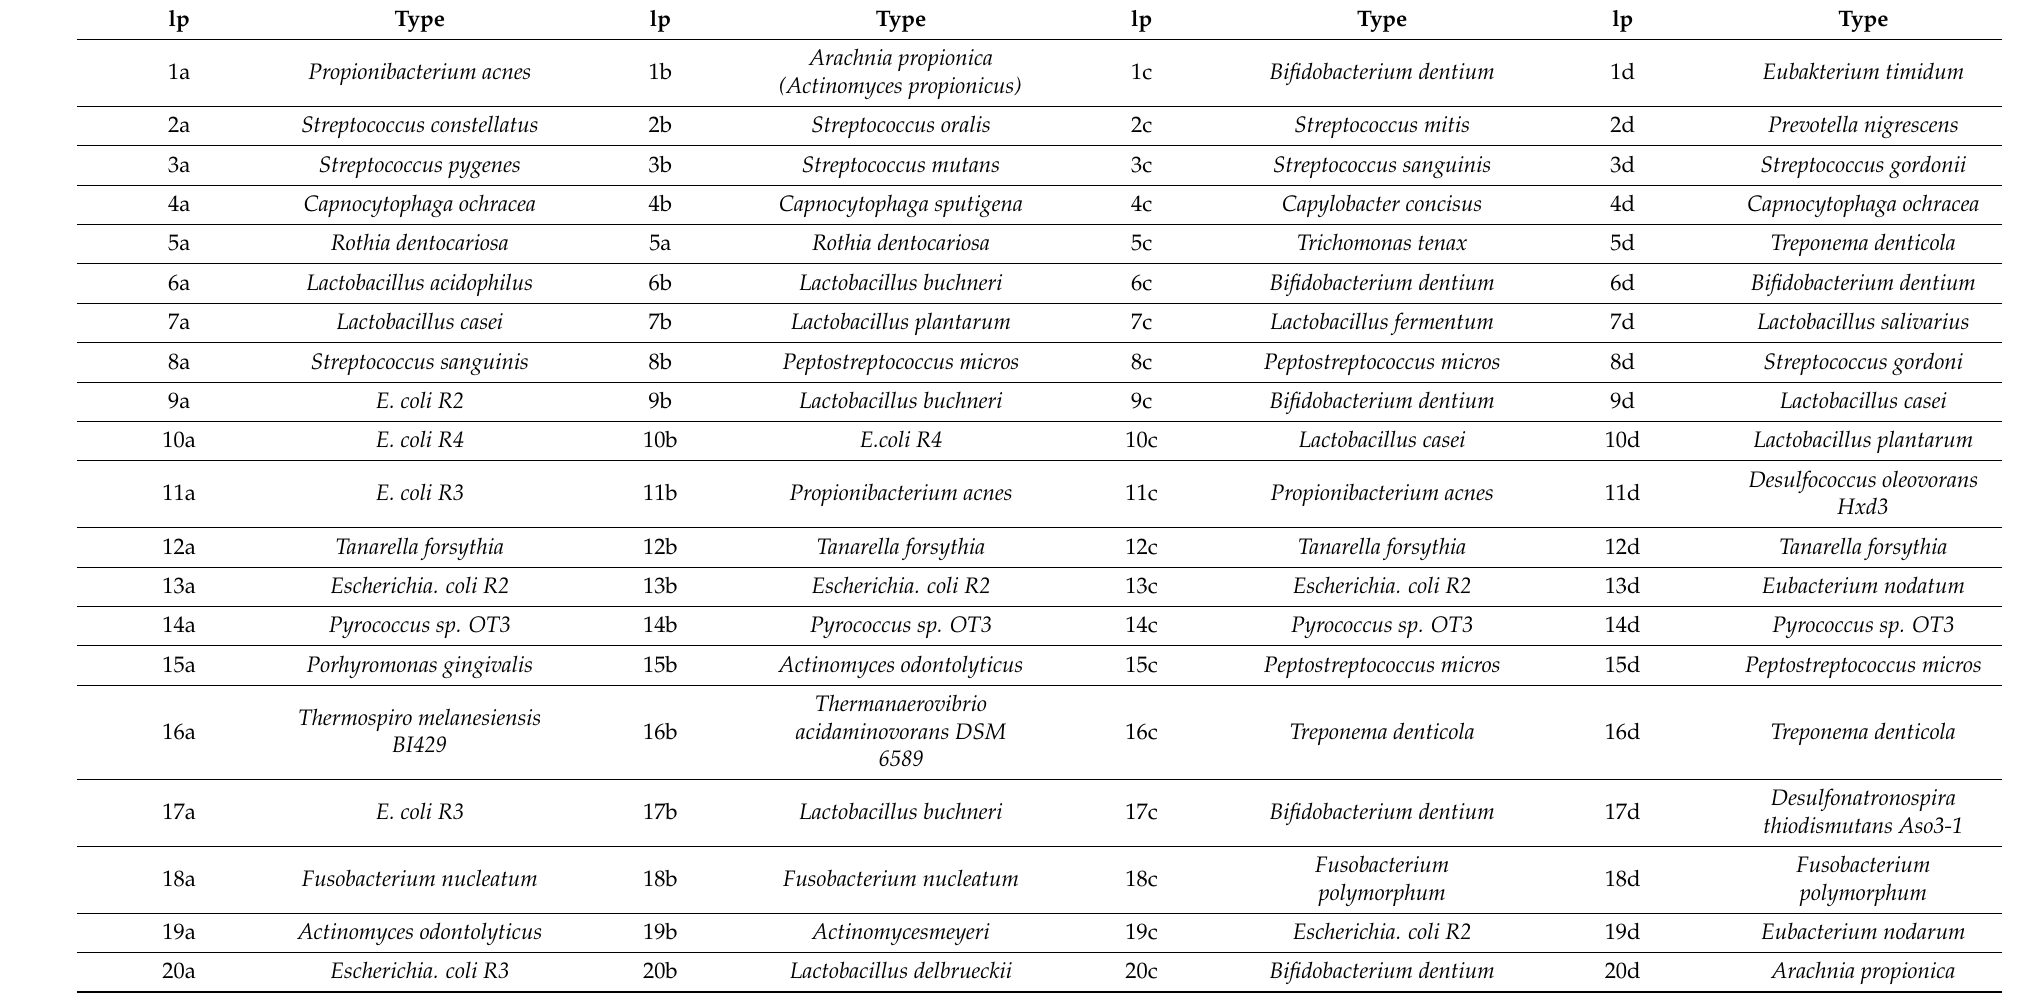
Table 3. Sanger sequencing of bacterial inoculum from specific dishes taken as A, B, C and